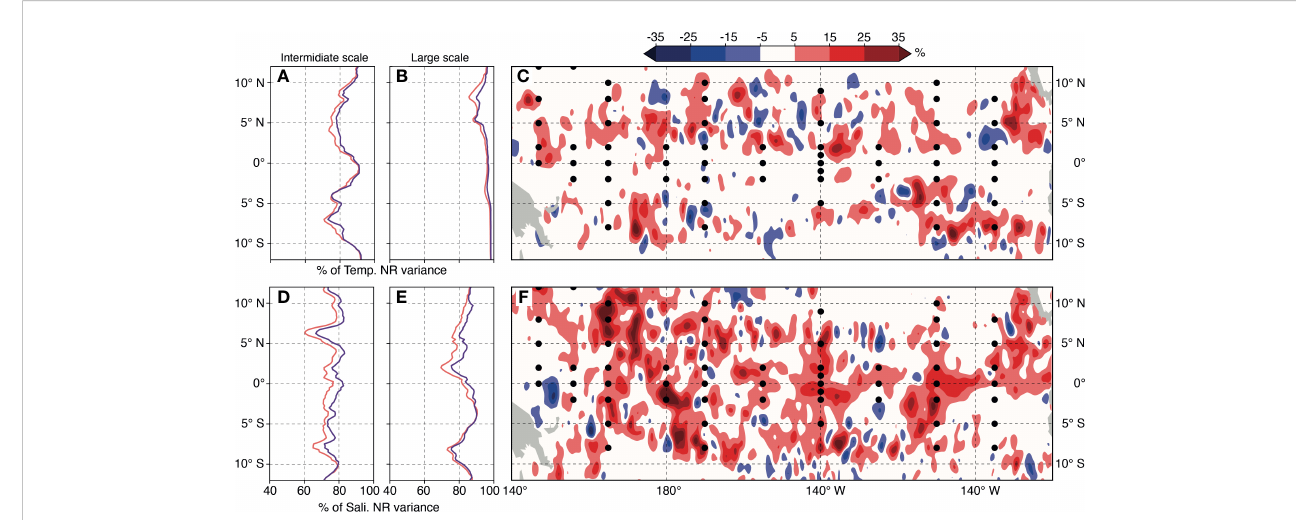
FIGURE 8 Zonally averaged percentage of Nature Run represented variance of NOMINAL (red) and ENHANCED_AR_MO (purple) experiments for the 0-100m temperature (A, B) and salinity (D, E) at intermediate and large scales. (C, F) ENHANCED_AR_MO-minus-NOMINAL difference of percentage of Nature Run represented variance at intermediate scales for the 0-100m (C) temperature and (F)